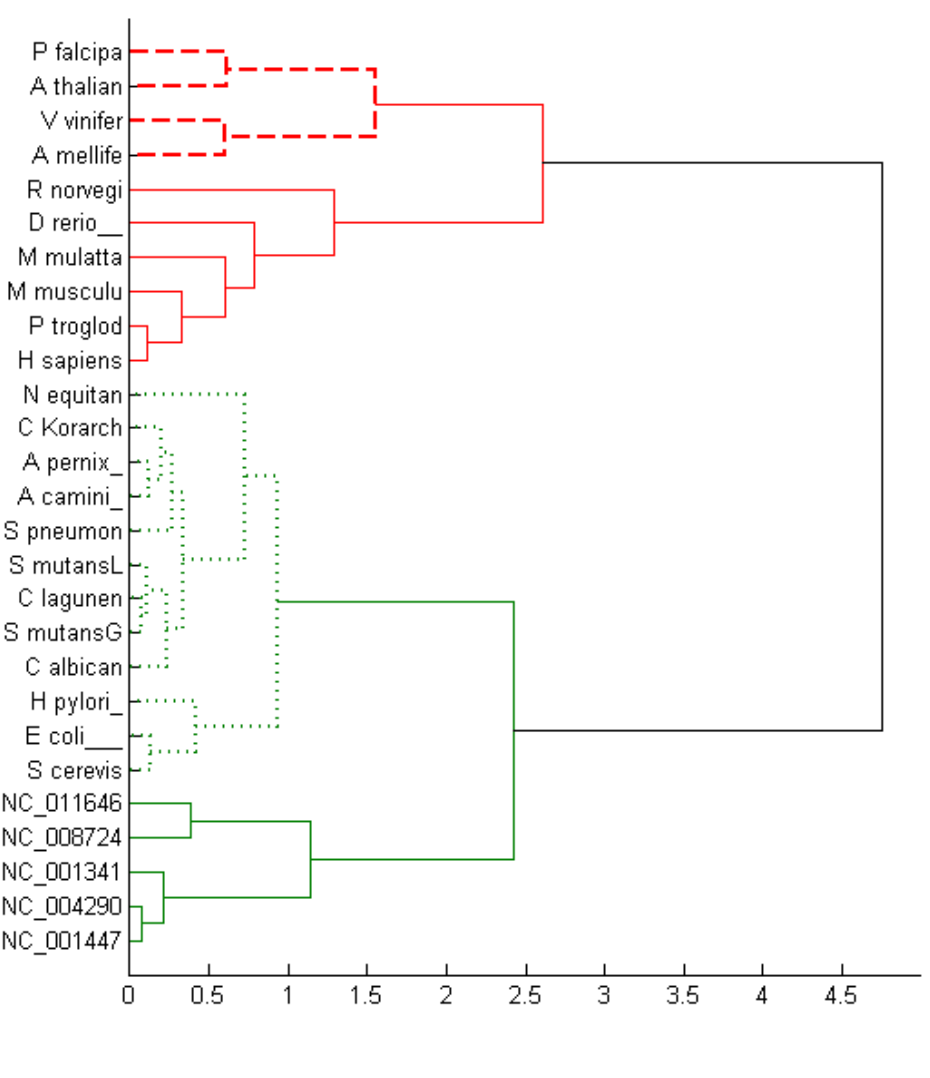
Figure 5: Dendrogram of all species under study. Using exceptional symmetry profiles for each species and Euclidean distance and